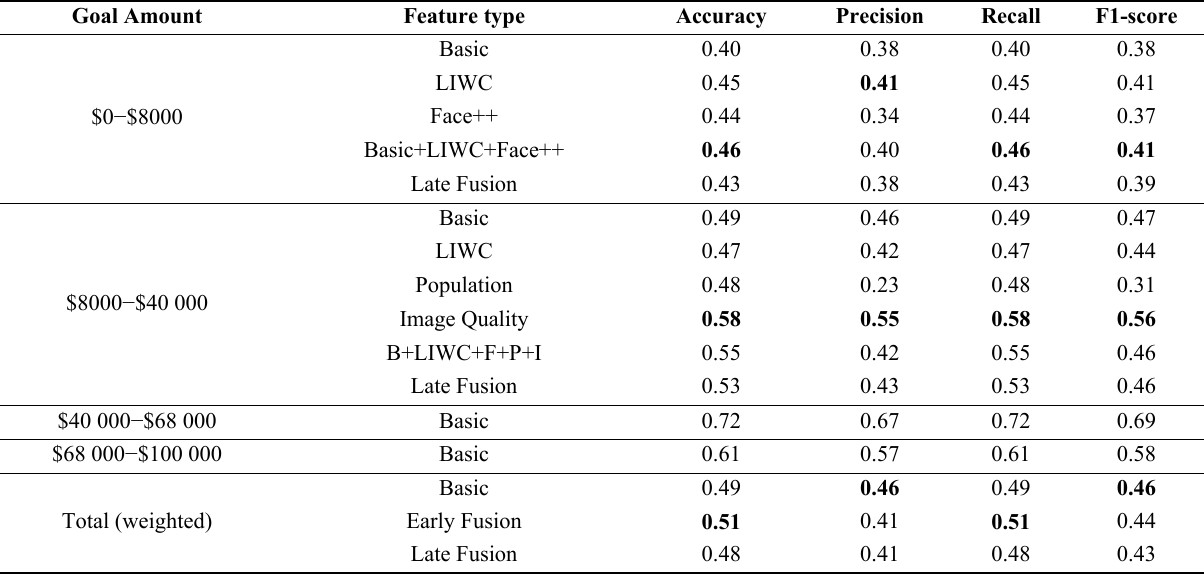
Table 5 Comparison of accuracy, precision, recall, and